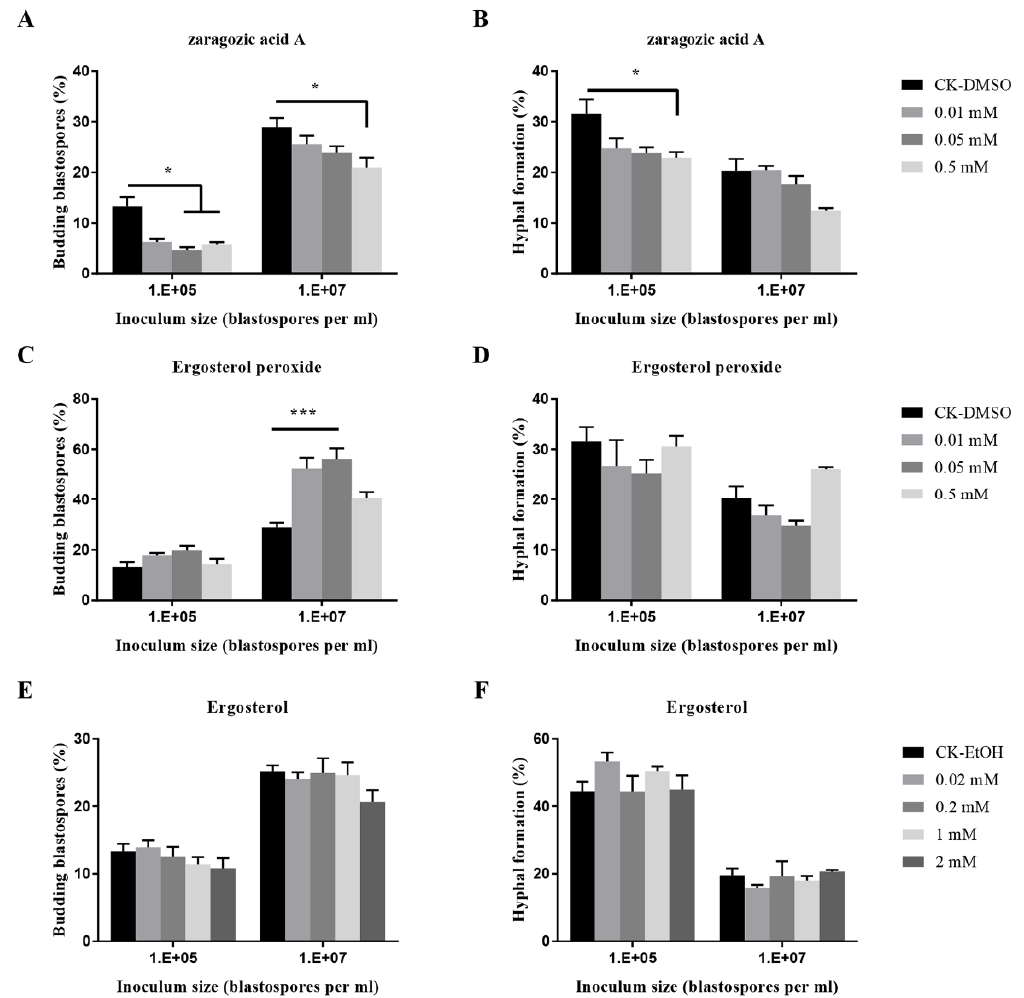
Figure 5. Effects of fungal metabolites on budding growth ( A,C,E ) and hyphal formation ( B,D,F ) of Figure 5. E ff ects of fungal metabolites on budding growth ( A , C , E ) and hyphal formation ( B , D , F ) of O. sinensis in liquid PM medium 8 days after inoculation. p < 0.05 (*) and p < 0.001 O. sinensis in liquid PM medium 8 days after inoculation. p < 0.05 (*), p < 0.01 (**) and p < 0.001 (***).